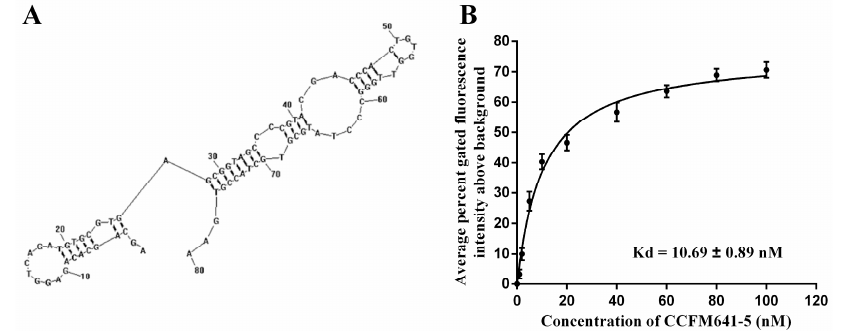
Figure 2. The secondary structure and binding ability of aptamer CCFM641-5 against B. bifidum . ( A ) The secondary structure of aptamer CCFM641-5. The secondary structure was predicted using RNAstructure 3.0. ( B ) The binding saturation curve of aptamer CCFM641-5 with B. bifidum . A nonlinear regression curve was fit according to the data from flow cytometric analysis using GraphPad Prism 5.0. The values of aptamer binding and K d represent the mean ± SD of three independent